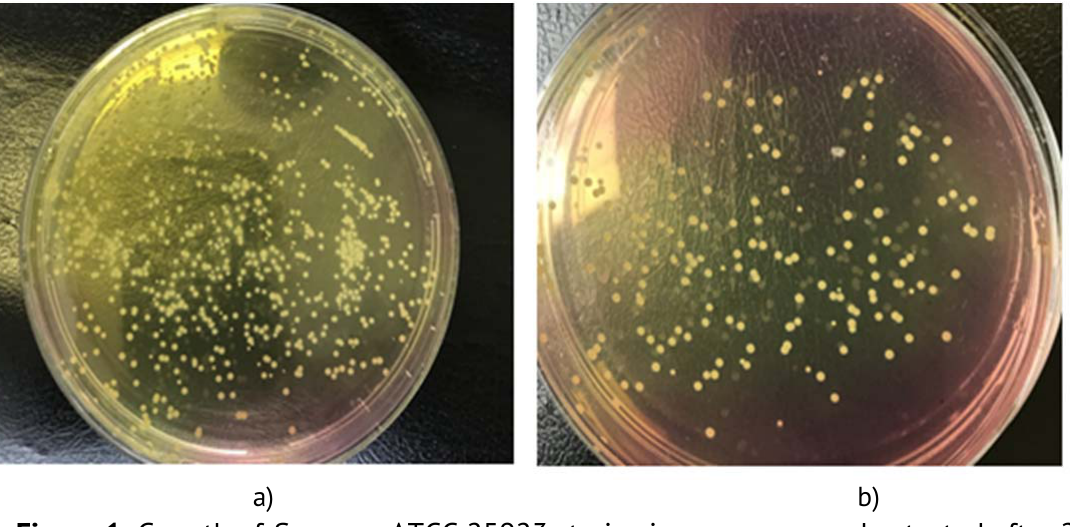
Figure 1. Growth of S. aureus ATCC 25923 strains in sausage samples tested after